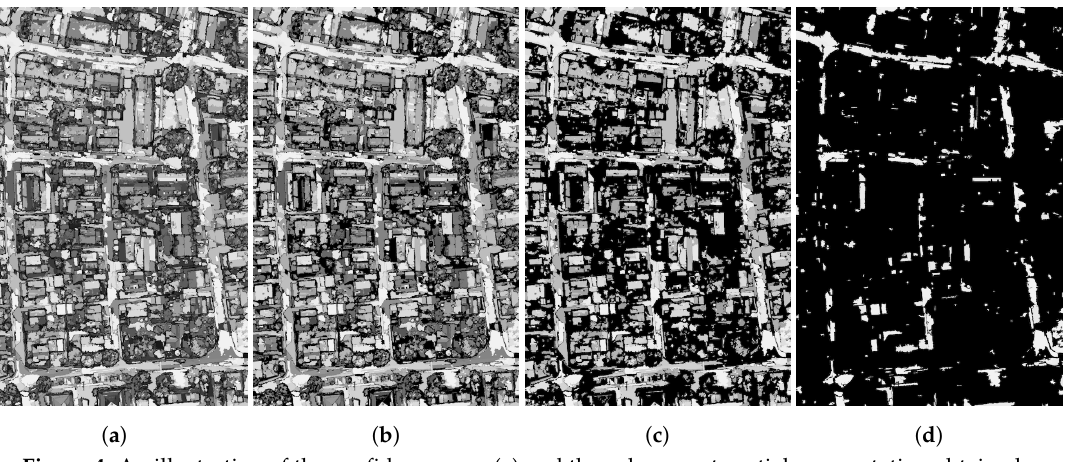
Figure 4. An illustration of the confidence map ( a ) and the subsequent partial segmentation obtained with a threshold of ( b ) α = 0.3, ( c ) α = 0.6, and ( d ) α = 0.9. The brighter tone corresponds to higher confidence, and darker tone to lower